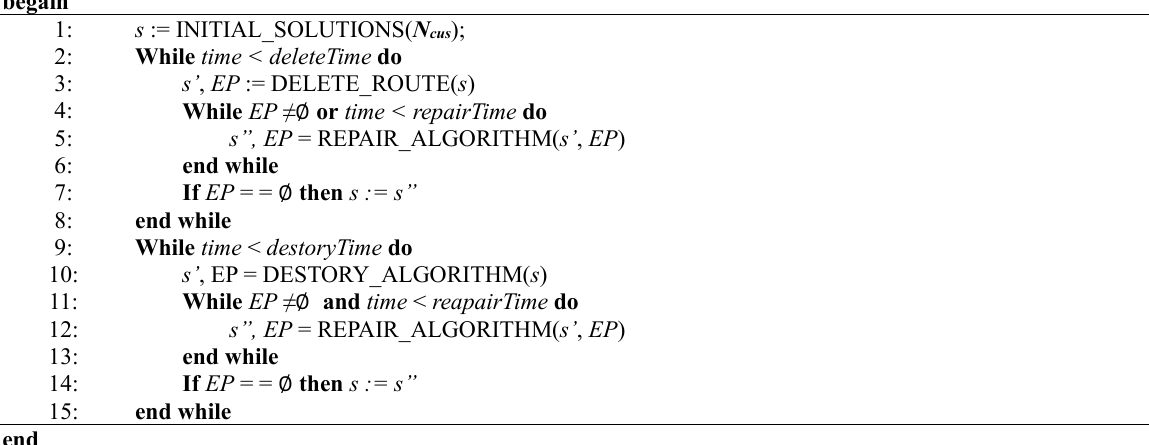
Fig. 2. Framework of the adaptive large neighborhood search.